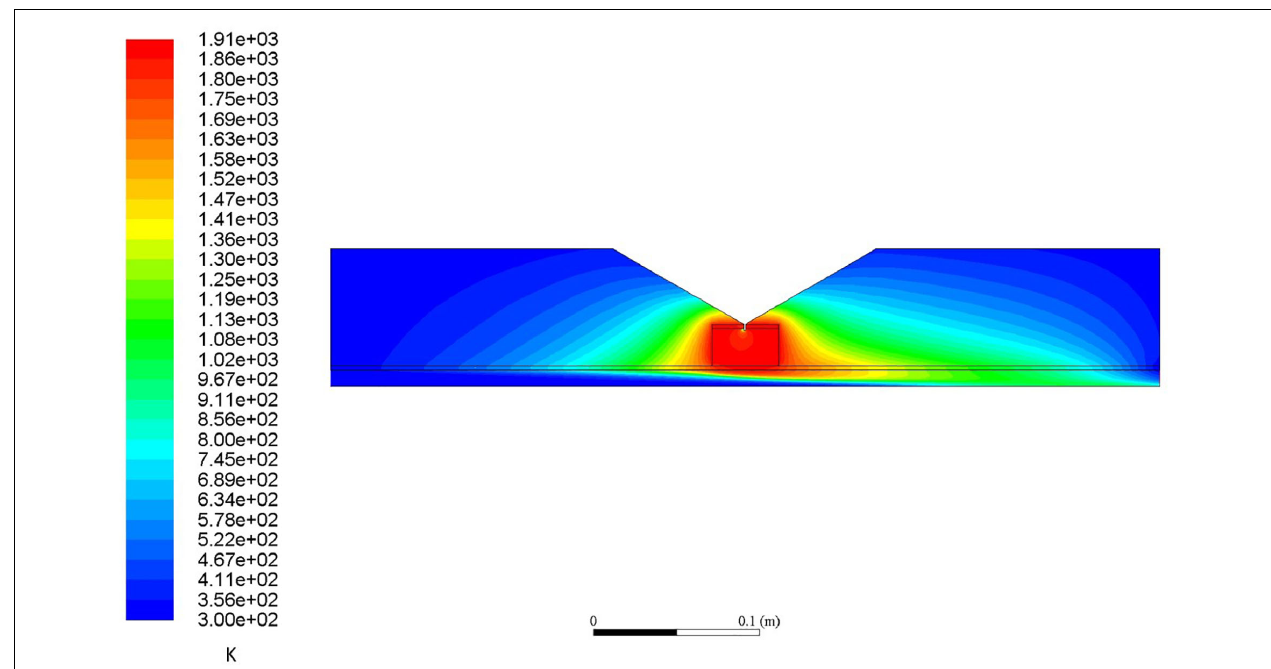
FIGURE 2 | Temperature contour for the single tube configuration